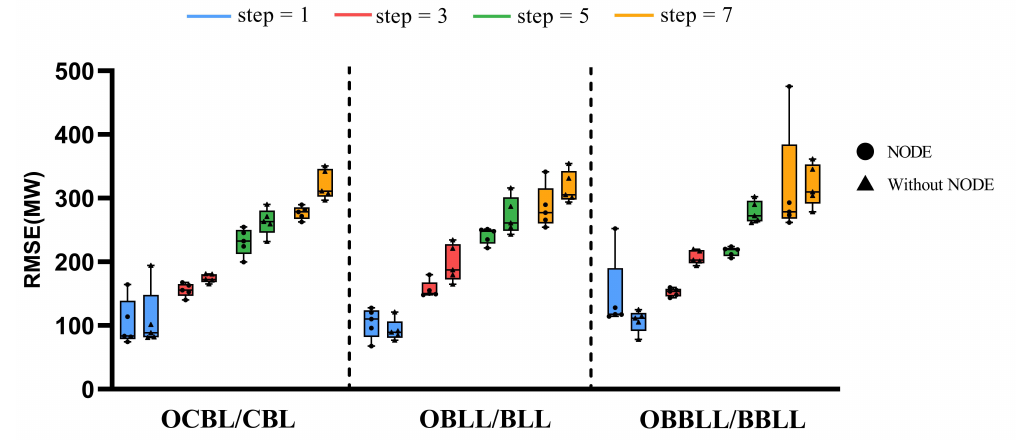
Figure 9. The RMSE metric comparison of three groups of models, respectively, in future steps 1, 3, 5, and 7 in Queensland in 2019. The dotted line divides the different comparative model groups. In each comparative model group, different colors represent different steps. The model with NODE is on the left side and the model without NODE is on the right